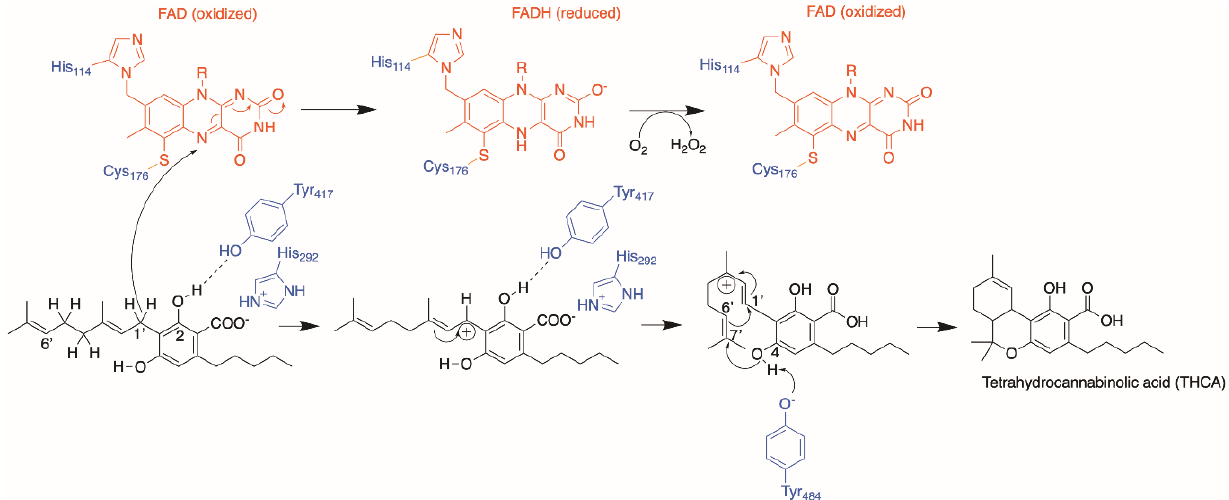
Figure 10. Proposed reaction mechanism of THCA synthase enzyme. The substrate and product are colored black; amino acid residues from THCA synthase are colored blue and the FAD moiety is colored red.